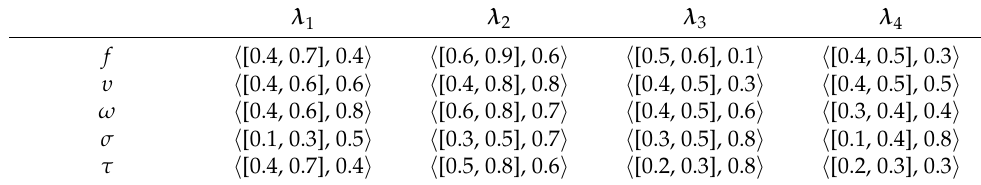
Table 3. ( Ω (cid:48) , (cid:60) (cid:48) ) is ( CS δ -SA ). λ 1 λ 2 λ 3 λ 4